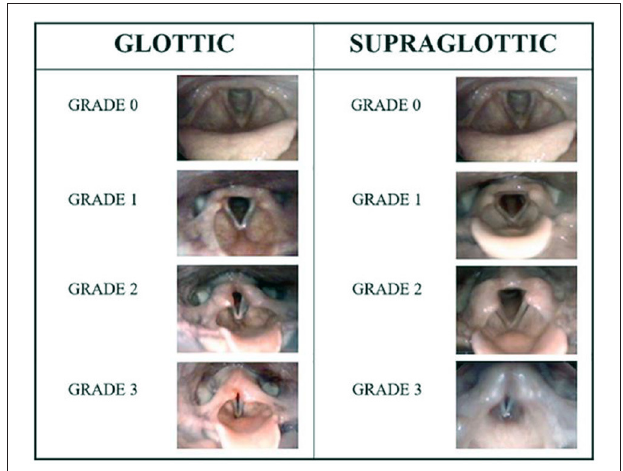
FIGURE 3 | CLE grading system, reproduced with permission from Fretheim Kelly et al., Frontiers in Physiology (